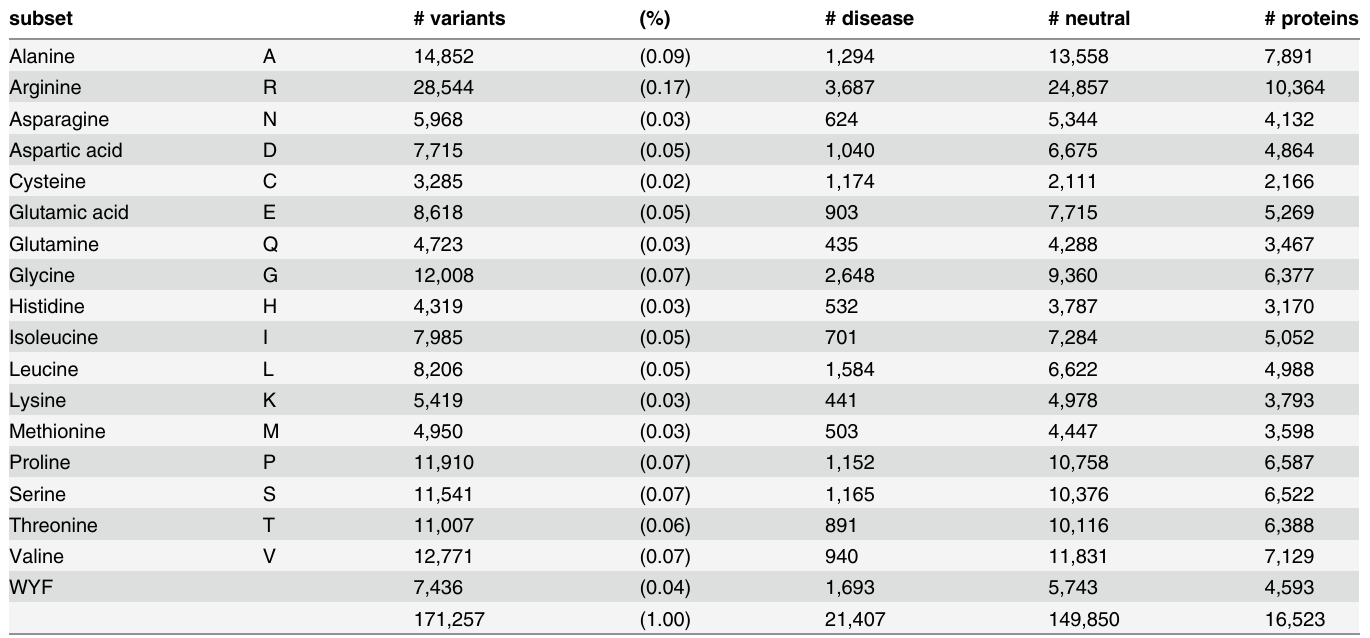
Table 1. Number of variants and proteins per